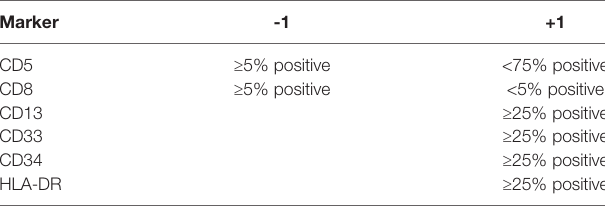
TABLE 2 | Scoring system based on six-marker combination (12). Marker -1